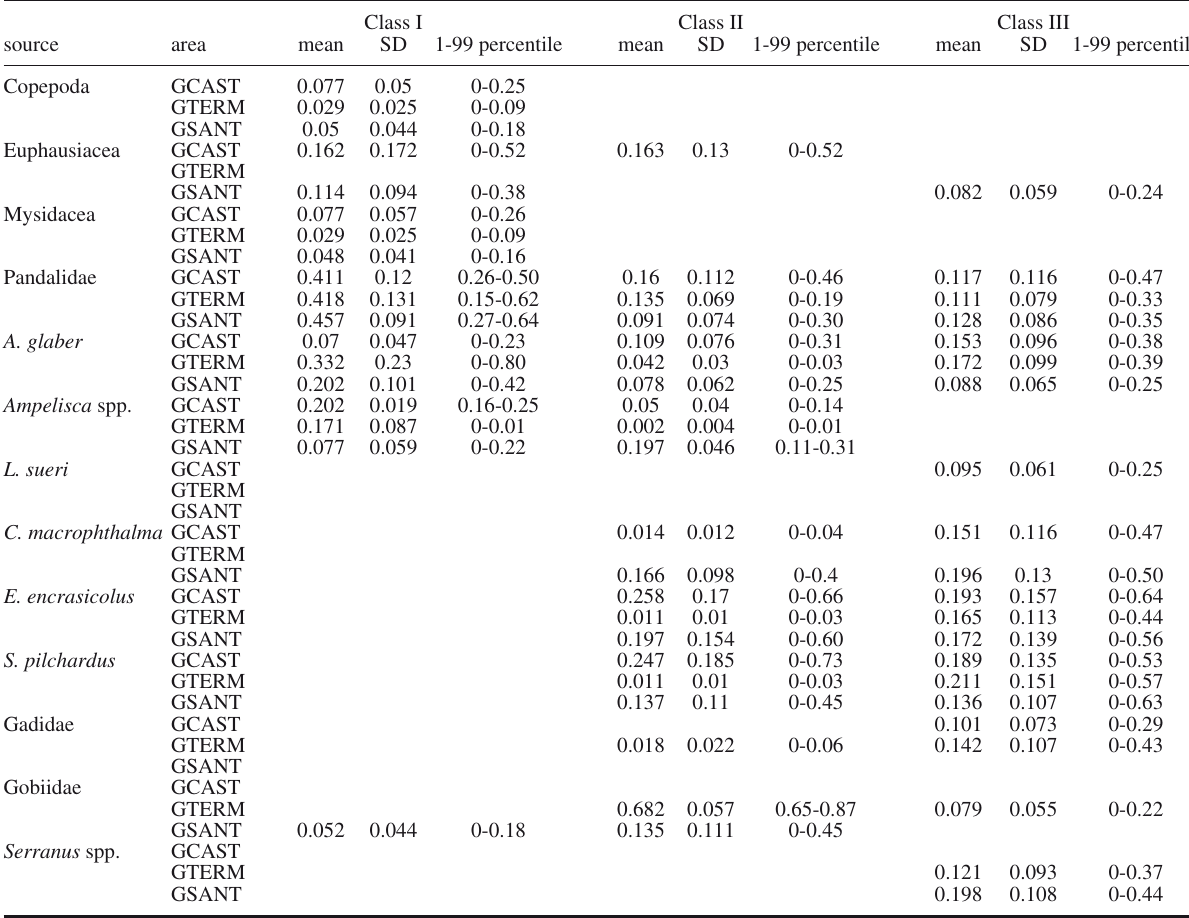
and δ 15 N. Class I, hake 60-120 mm TL; Class II, lipidfree of